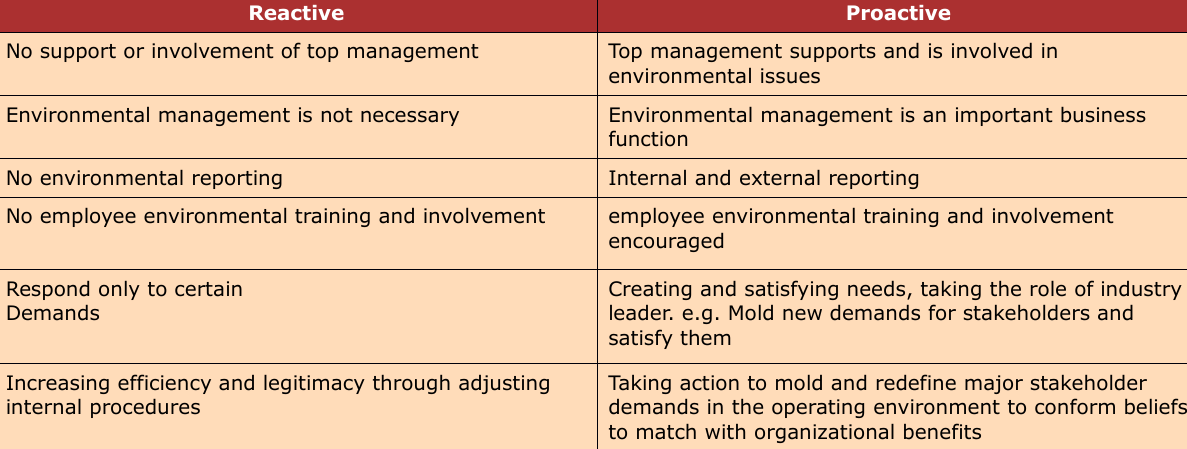
Table 1. Typology of CSR Strategy (Hendriques & Sadorsky, 1999; Fang et al .,